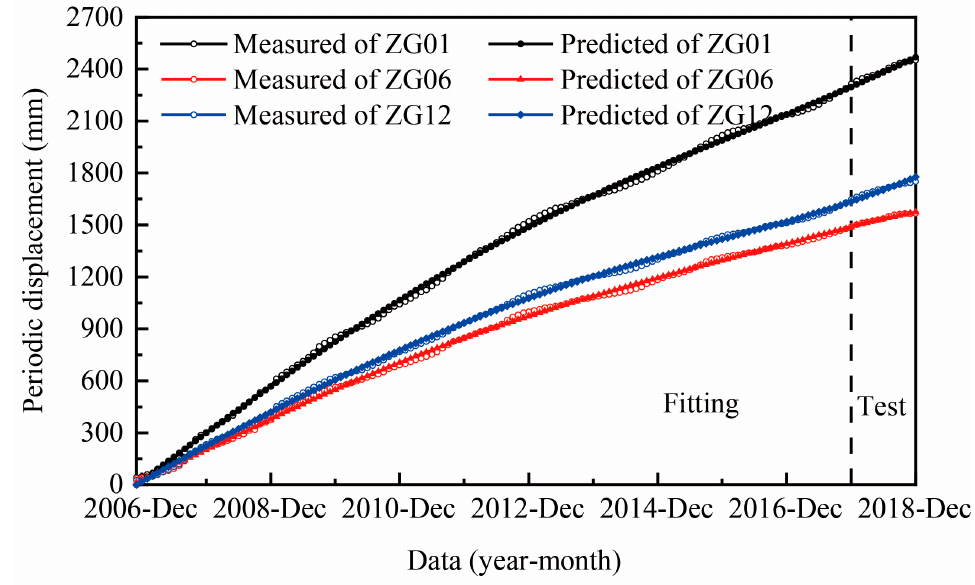
Figure 8. A comparison of the predicted and measured trend displacements. Table 2. The coefficients of the trend displacement polynomial function (Equation (14)).